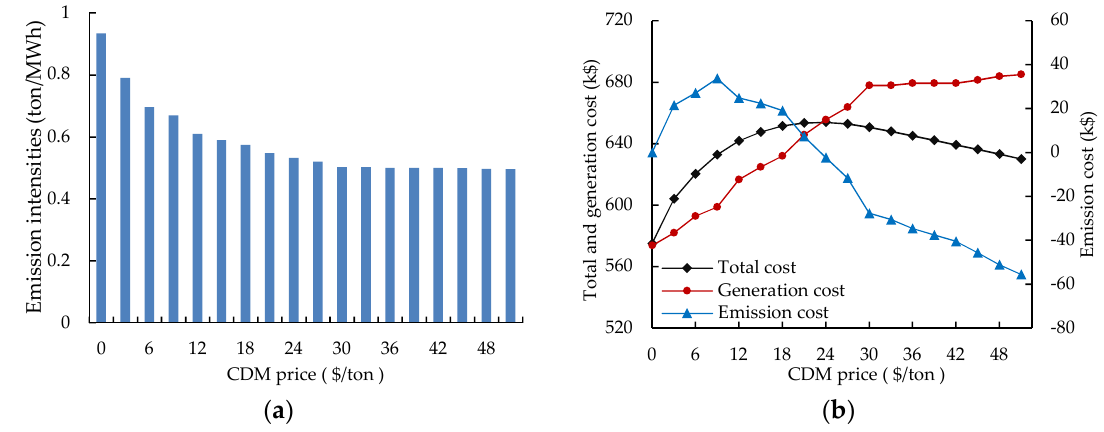
Figure 6. The generation scheduling results under different CDM prices: ( a ) CO 2 emission intensities; ( b ) Generation cost, CO 2 emission cost, and total cost.